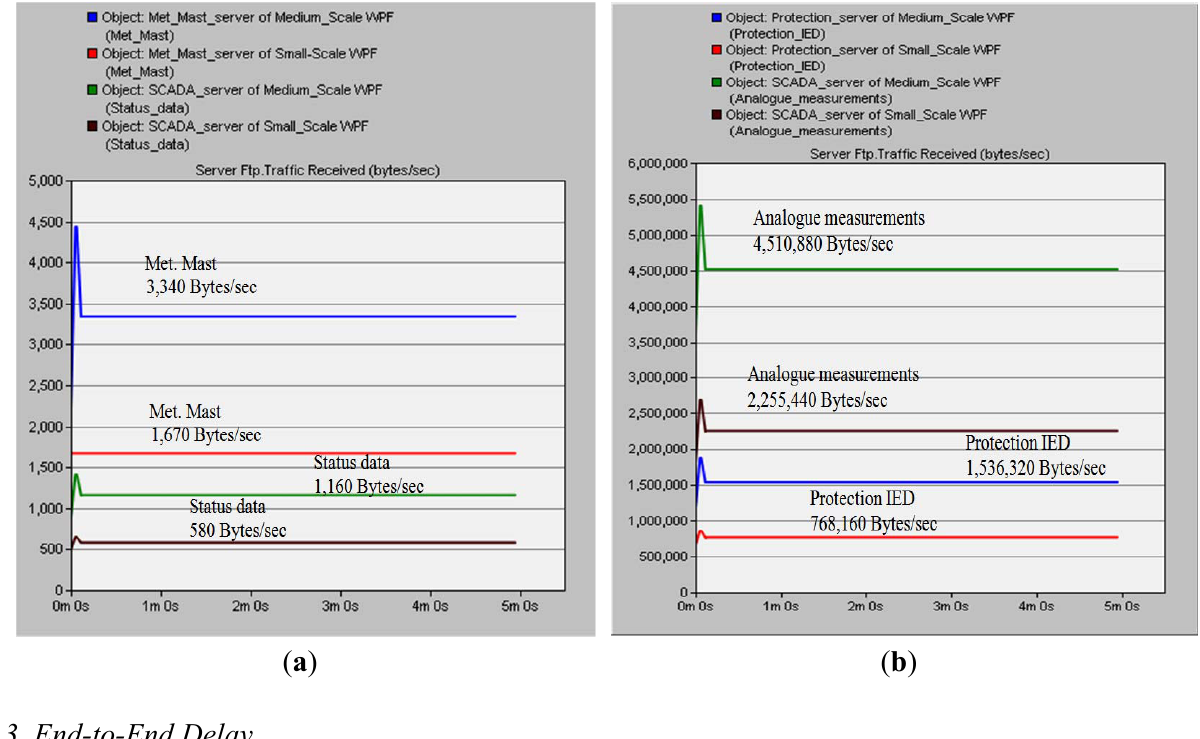
Figure 10. Traffic received at the control center servers. ( a ) Meteorological mast and status information; ( b ) Analogue measurements and protection information.